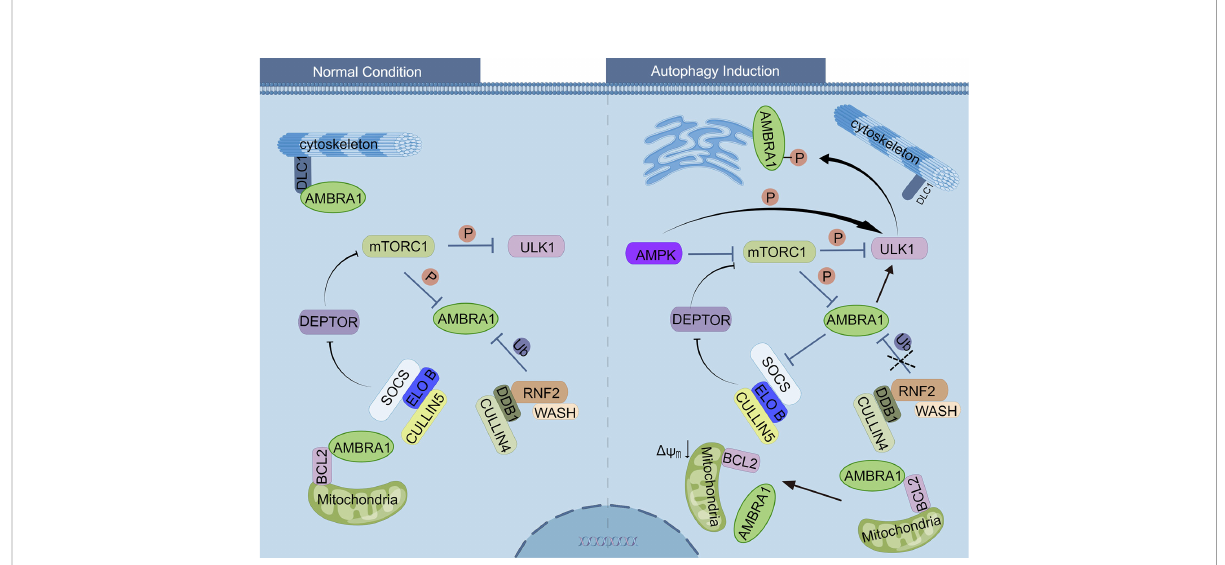
FIGURE 2 Regulation of AMBRA1 under normal conditions and autophagy induction. Left side: under normal conditions, AMBRA1 is relocated to the cytoskeleton through an interaction with DLC1, as well as with BCL-2 at the outer mitochondrial membrane. The mTORC1 inhibits ULK1 and AMBRA1 by phosphorylating ULK1 and AMBRA1, respectively. RNF2/DDB1/CULLIN4, together with WASH protein, ubiquitylates and degrades AMBRA1. SOCS/ELONGIN B/CULLIN5 ubiquitylates and degrades DEPTOR, resulting in activation of mTORC1 complex. Right side: upon autophagy induction of glucose starvation, AMPK inhibits mTORC1 and then reduces the phosphorylation of ULK1 and AMBRA1. Subsequently, AMPK directly interacts and activates the ULK1 by phosphorylation, and the dephosphorylated AMBRA1 ubiquitylates ULK1 to further promote the activity of ULK1. The activated ULK1 kinase phosphorylates AMBRA1, promotes its release from dynein motor complex, and relocates to mitochondria-associated membranes (MAMs). The degradation of AMBRA1 by RNF2/DDB1/CULLIN4 is inhibited, and therefore, AMBRA1 promotes DEPTOR accumulation and inhibits mTORC1 activity. The interaction between AMBRA1 and mito-BCL-2 is disrupted when mitophagy